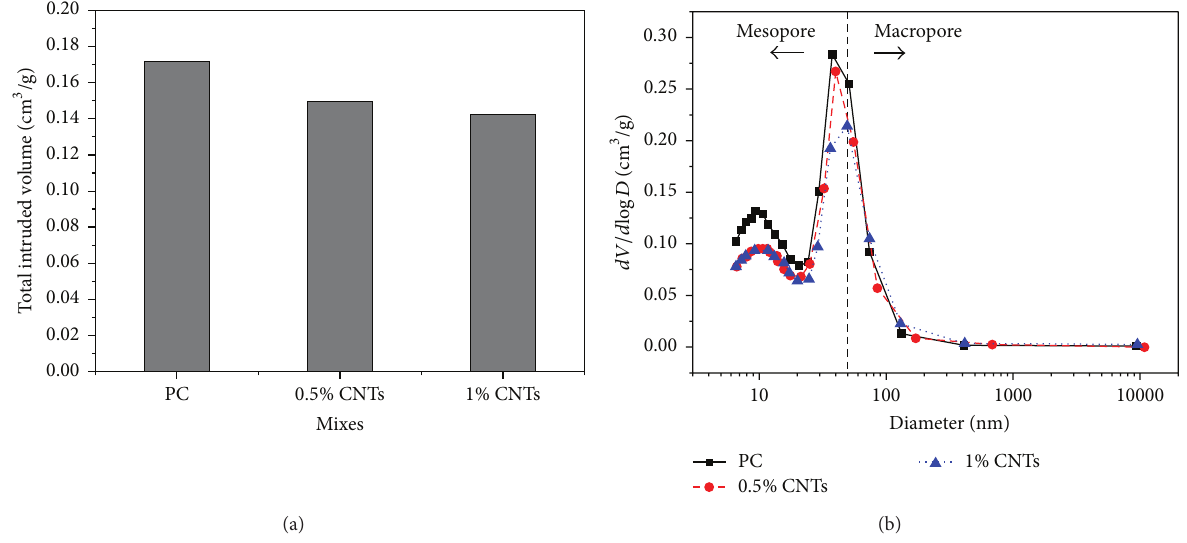
Figure 8: MIP analyses of CNTs-cement pastes: (a) total pore volume and (b) pore size distribution [102].